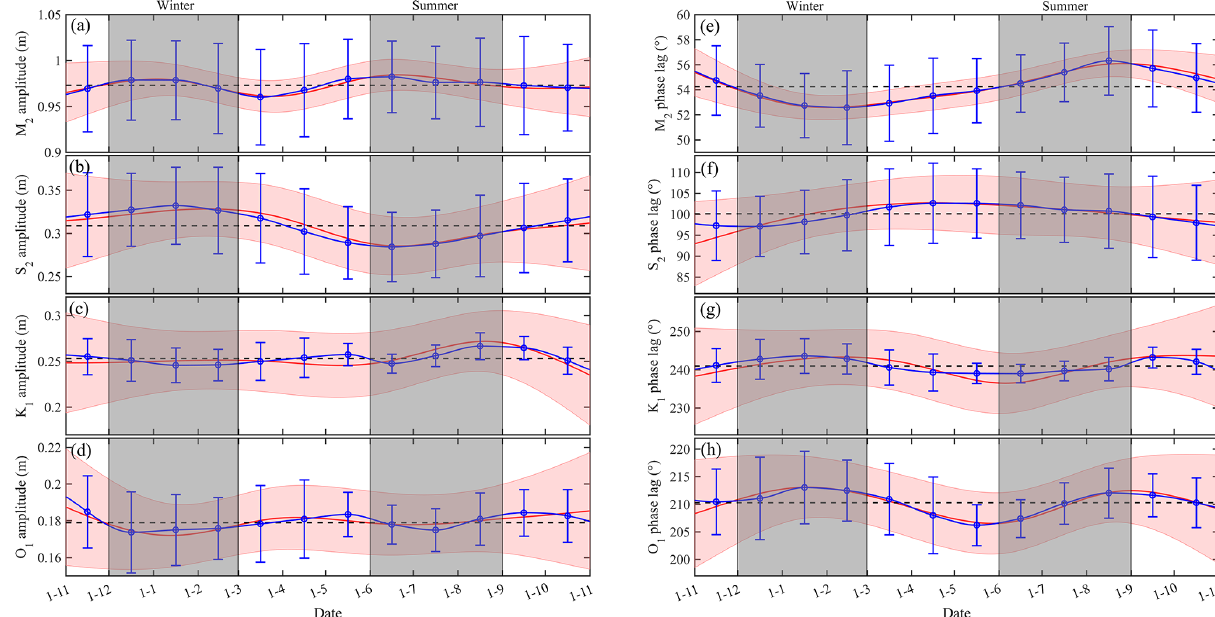
Figure 6. Similar to Fig. 4 but for multi-yearly averaged values at Dalian. Table 2. Averaged amplitudes (cm) and phase lag ( ◦ ) of the principal tidal constituents obtained using EHA at Dalian.